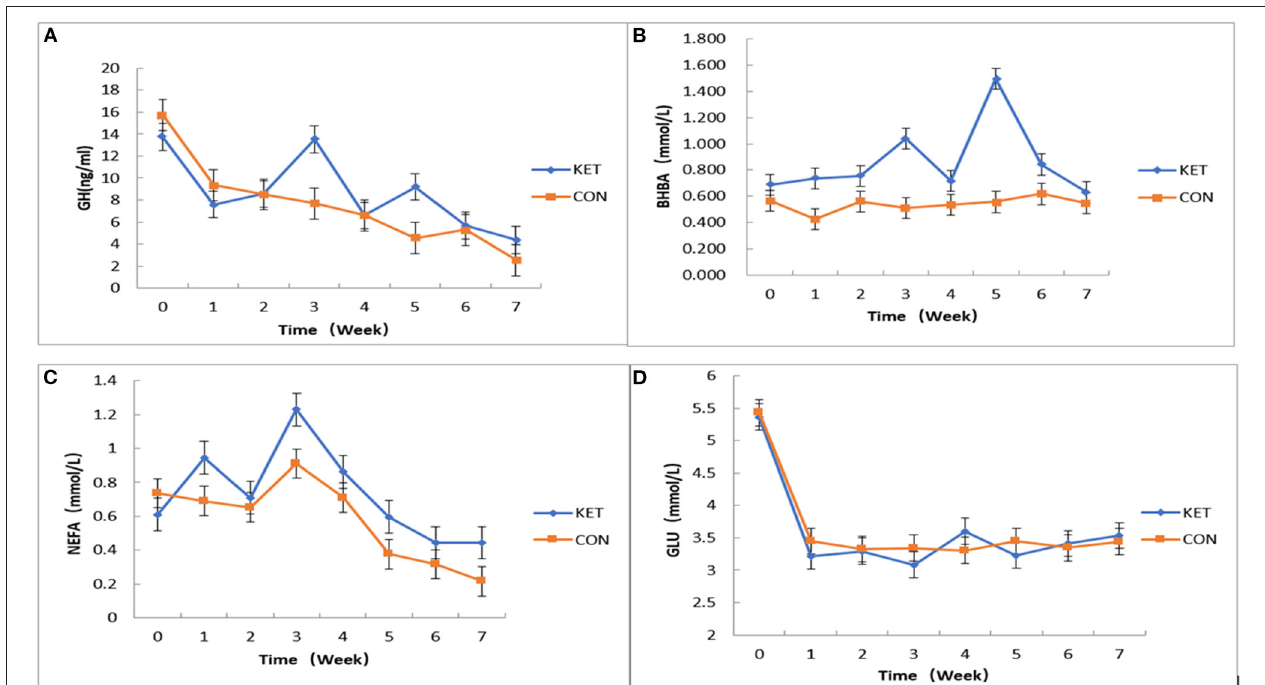
FIGURE 2 | The effects of plasma levels of GH, BHBA, NEFA, and GLu on SCK and CON healthy dairy cows monitored weekly eight times. (A) The effect of plasma levels of GH on SCK and CON ( p = 0.5512) healthy dairy cows during 0 to 7 weeks postpartum ( p = 0.0416). (B) The effect of plasma levels of BHBA on SCK and CON ( p = 0.7469) healthy dairy cows during 0 to 7 weeks postpartum ( p = 0.0076). (C) The effect of plasma levels of NEFA on SCK and CON ( p = 0.9519) healthy dairy cows during 0 to 7 weeks postpartum ( p = 0.0047). (D) The effect of plasma levels of GLu on SCK and CON ( p = 0.8082) healthy dairy cows during 0 to 7 weeks postpartum ( p = 0.0001).